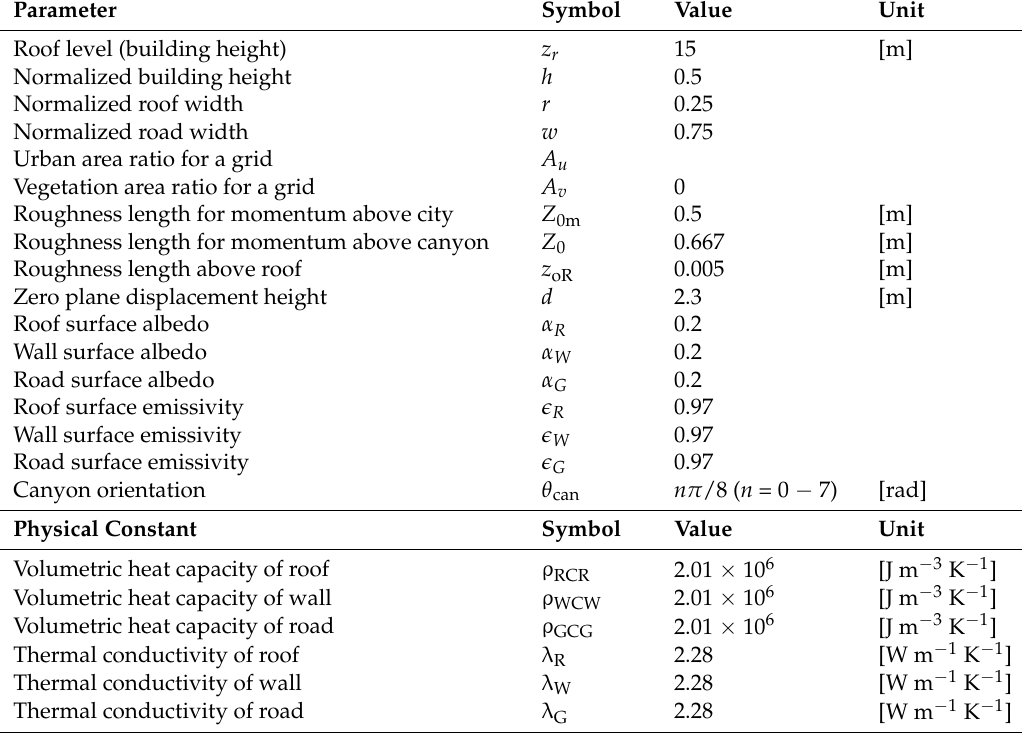
Table 1. Surface parameters, canyon dimensions, and physical constants used in WRF runs (credit to WRF user’s manual).